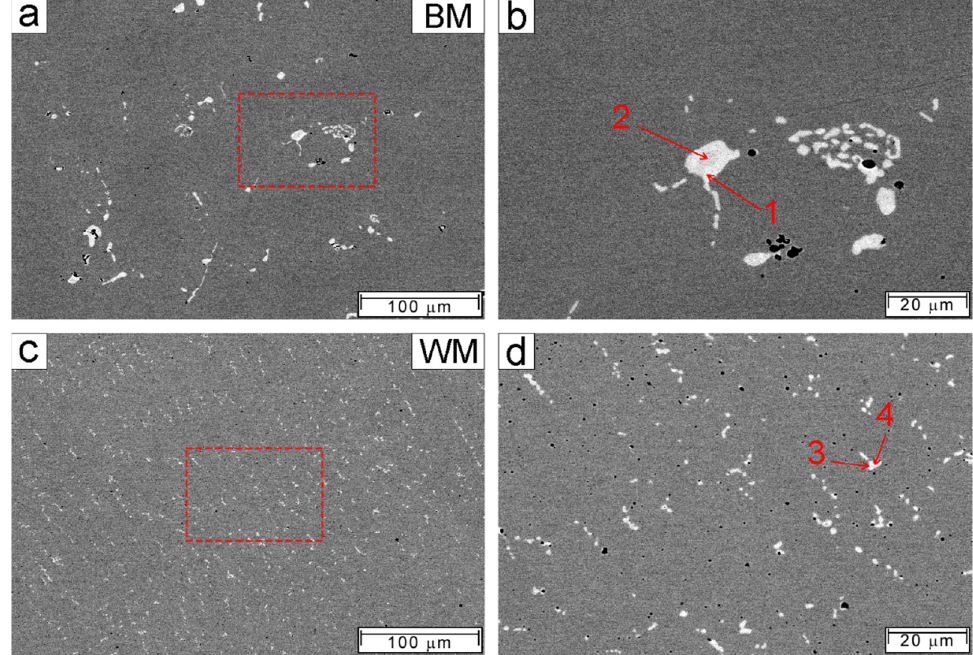
Figure 4. SEM micrographs of distinct welding regions of the multi-pass shielded metal arc welded CW6MC butt joint: BM ( a , b ); WM ( c , d ).